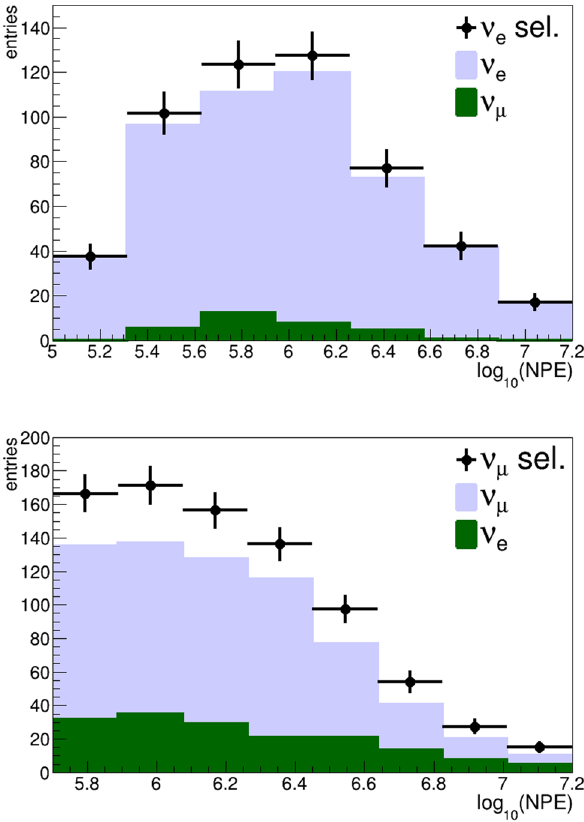
Fig. 5 Distribution of the observable log 10 (NPE) in the analysis bins, after the ν e selection (top) and the ν μ selection (bottom). The black dots represent the number of selected events in every bin j , with associated statistical error. The filled histograms reproduce the bin composition, in terms of the correct flavor (light blue) and wrong flavor (green)